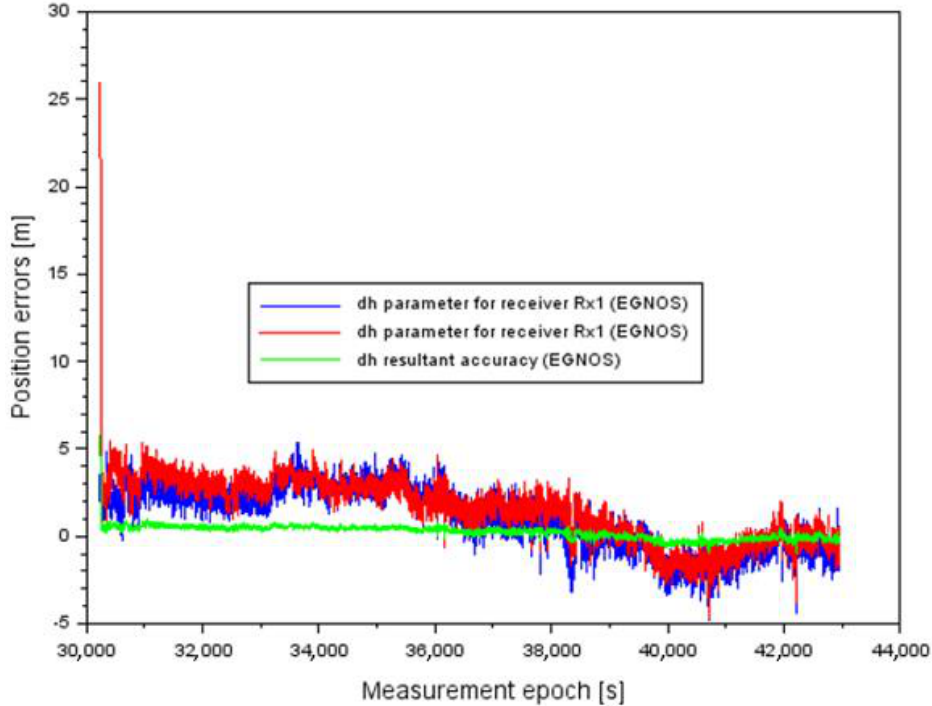
Figure 16. The results of 𝑑ℎ position errors for EGNOS solution.